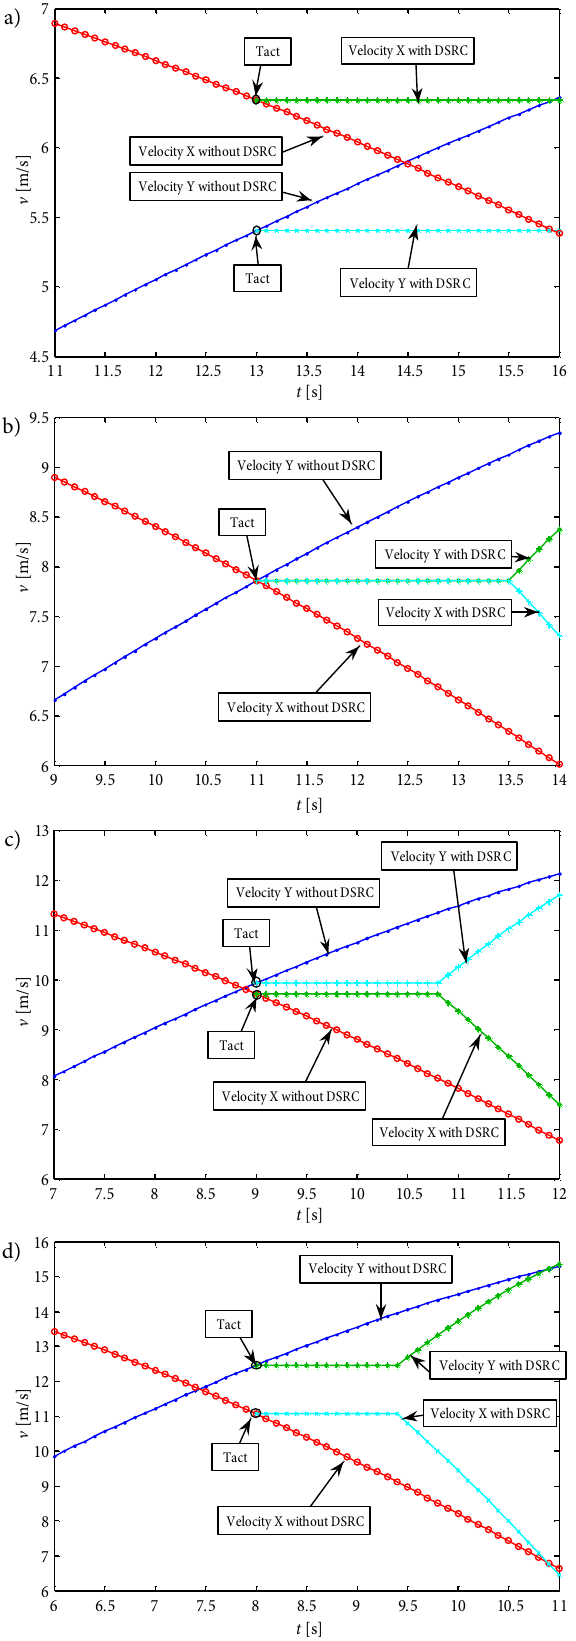
Fig. 8. Change in the velocity of the host vehicle in both axes over time: a – v host = 30 km/h; b – v host = 40 km/h; c – v host = 50 km/h; d – v host = 60